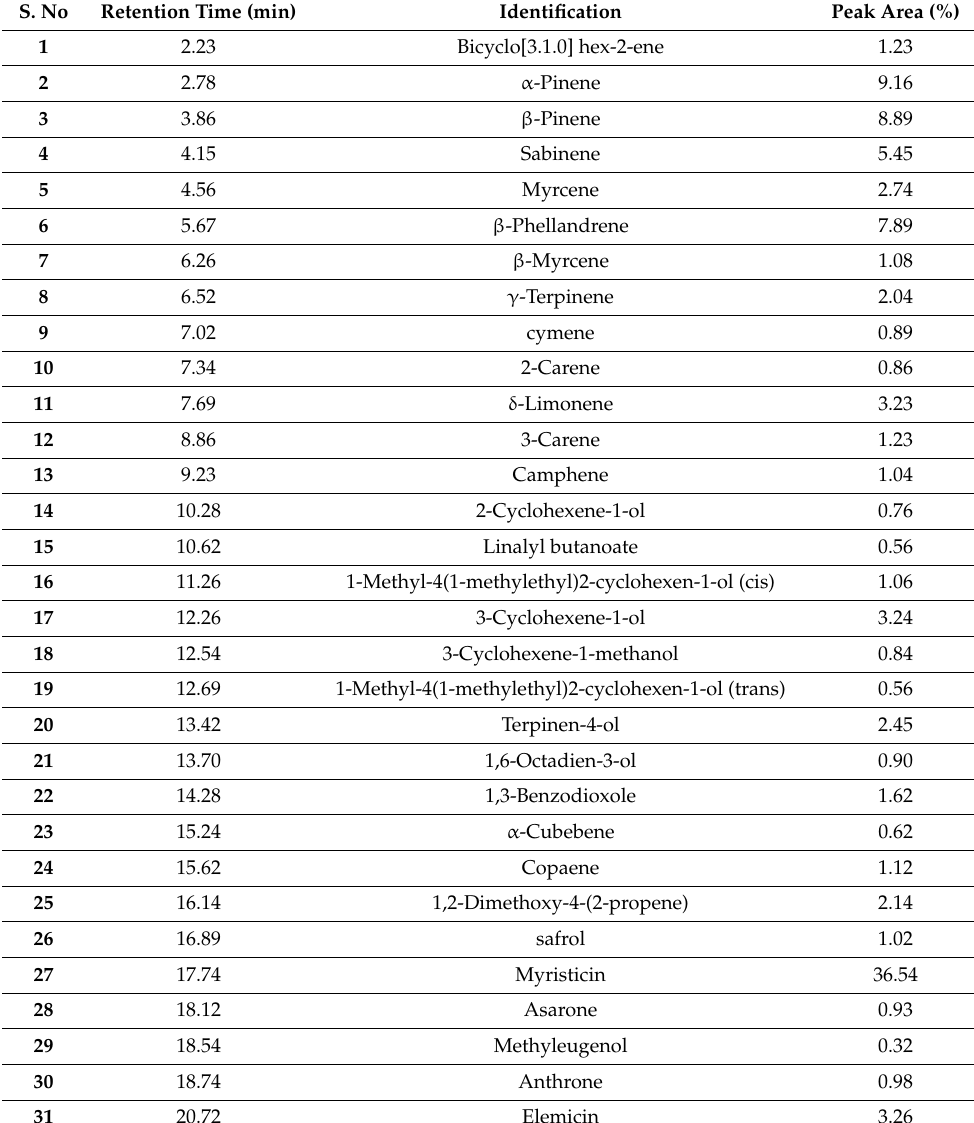
Table 1. Chemical analysis of nutmeg oil by